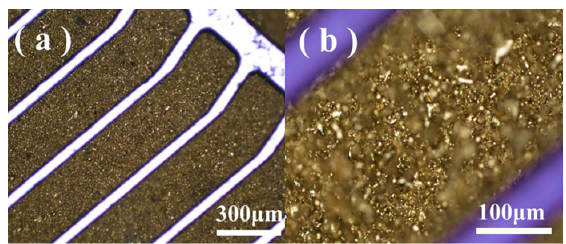
Figure 7. Upper surface of the sample obtained by sintering (650 °C) the 20 µm diameter pre-alloyed powder in the trench structure with ( a ) 50× and ( b ) 200× magnifications.